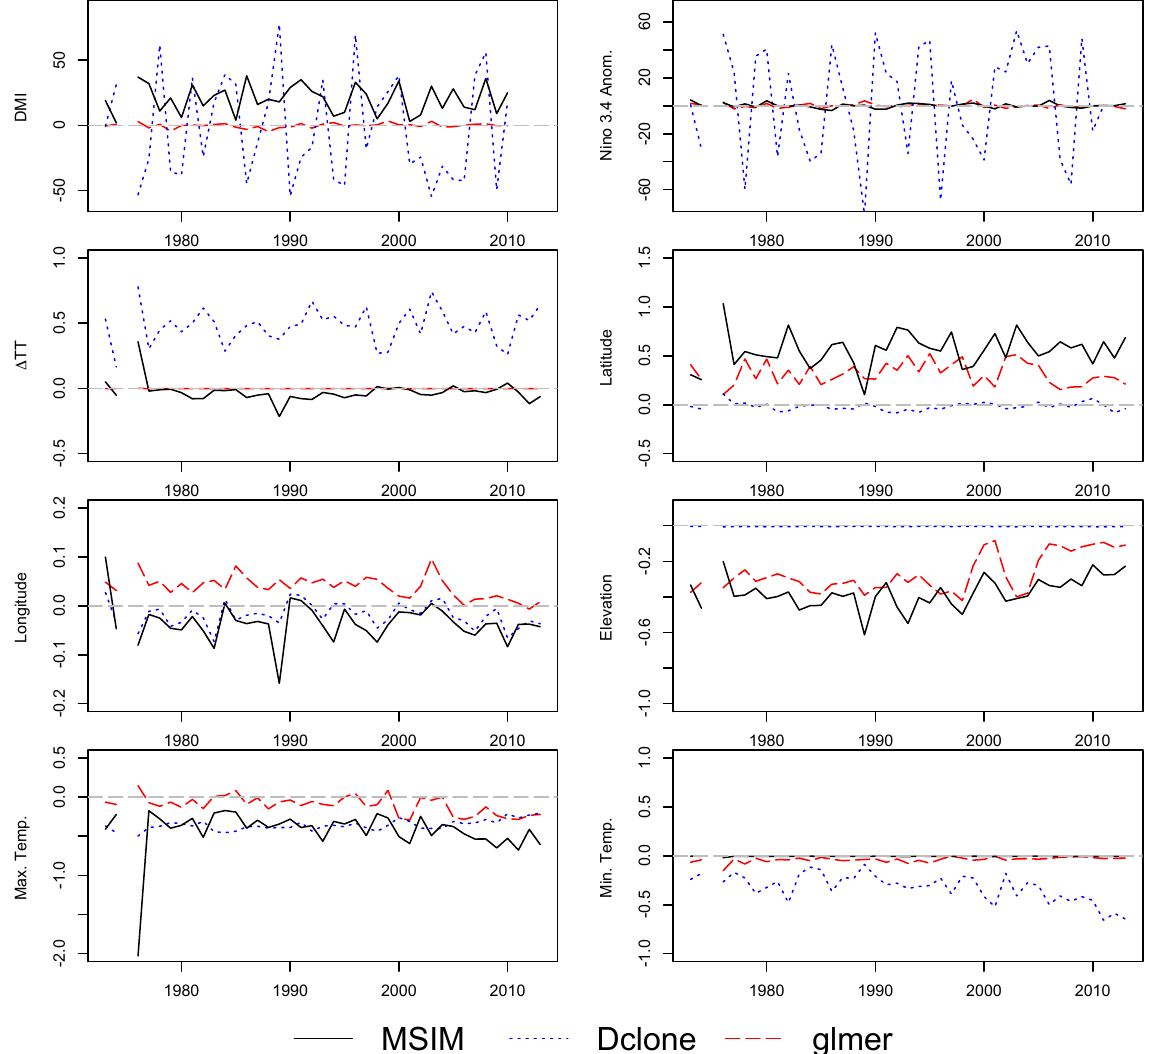
Figure 4. Fixed coefficient estimates for logit-normal models with moderate Indian rainfall (64.4 ≤ x < 124.4mmday − 1 ) response from